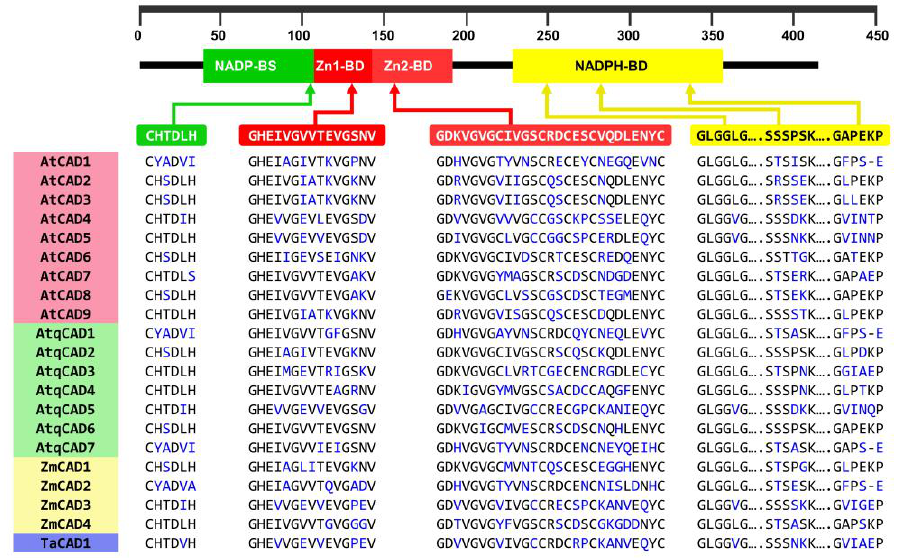
Figure 4. Motif alignment of AtqCADs with CADs from other species. Arabidopsis thaliana, (AtCAD) Agave tequilana (AtqCAD), Zea mays (ZmCAD), and Triticum aestivum (TaCAD). Non-conserved residues are highlighted in blue.